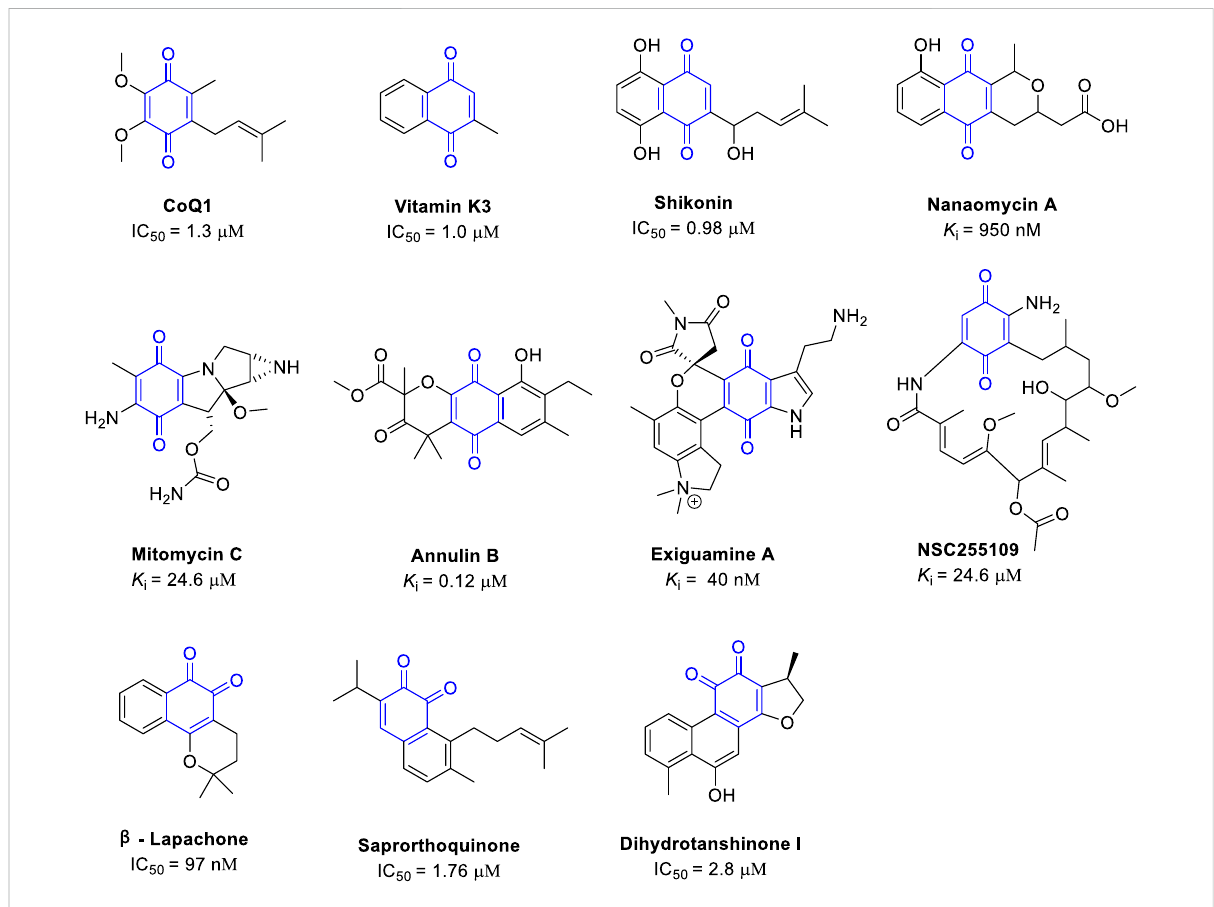
FIGURE 4 Structures of natural 1, 2- and 1, 4-quinones with their IDO1 inhibitory